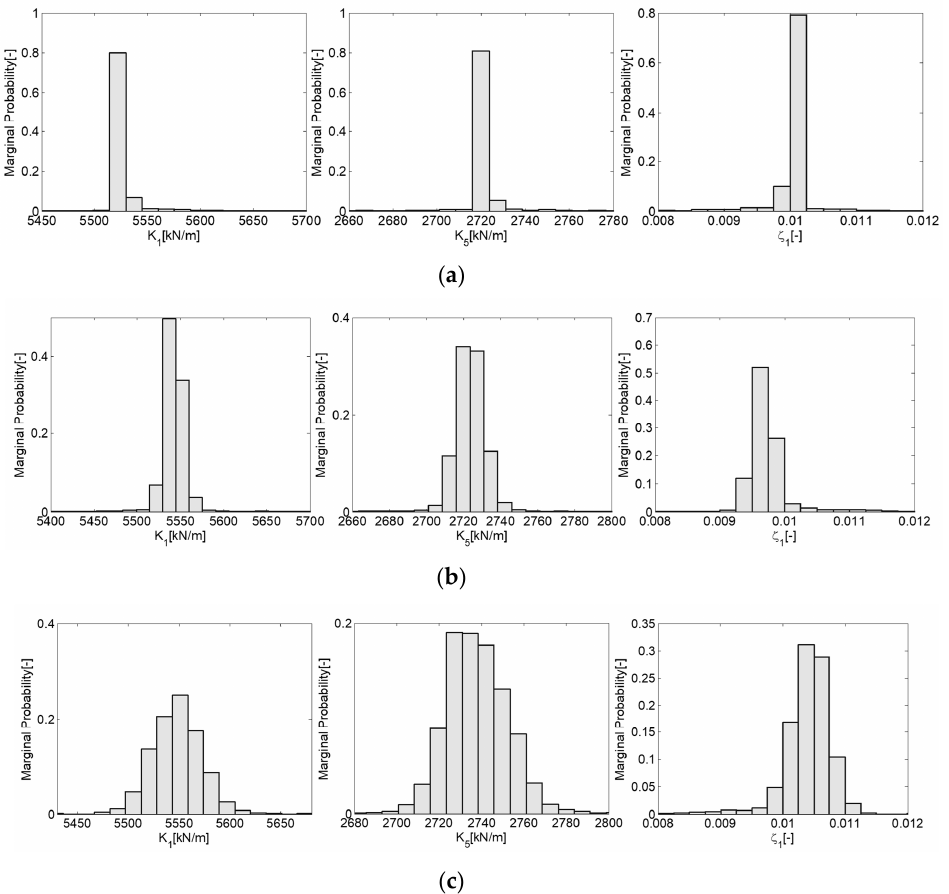
Figure 5. Marginal posterior probability distributions of the three estimation parameters ( k 1 , k 5 , ζ 1 ): ( a ) Case 1: 0% noise + Full Outputs; ( b ) Case 2: 10% noise + Full Outputs; ( c ) Case 3: 10% noise + Partial